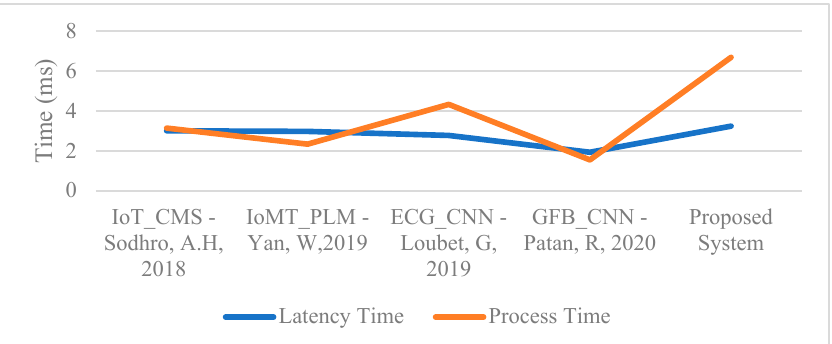
Figure 7. Performance evaluation by latency and Process Times [1,2,4,34].